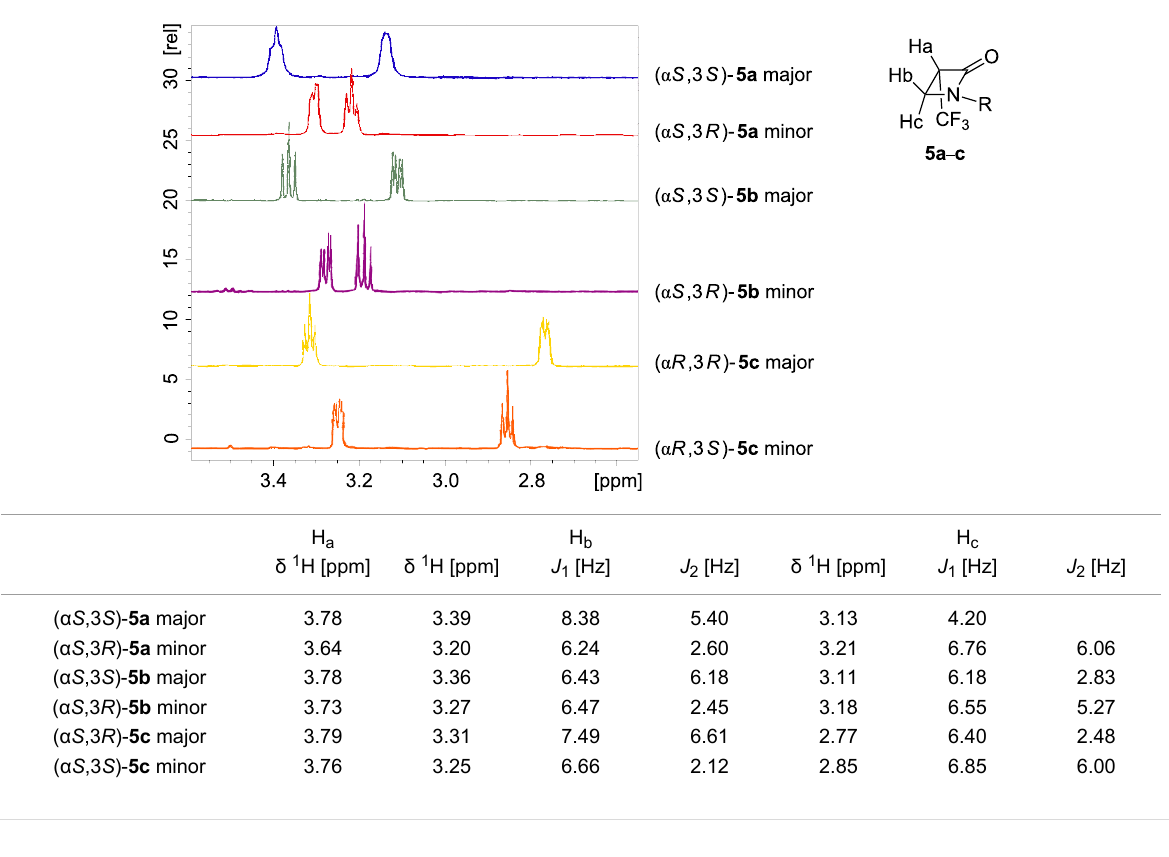
Table 1: Comparison of the 1 H NMR data of Hb and Hc of the diastereoisomers of 5a – c .